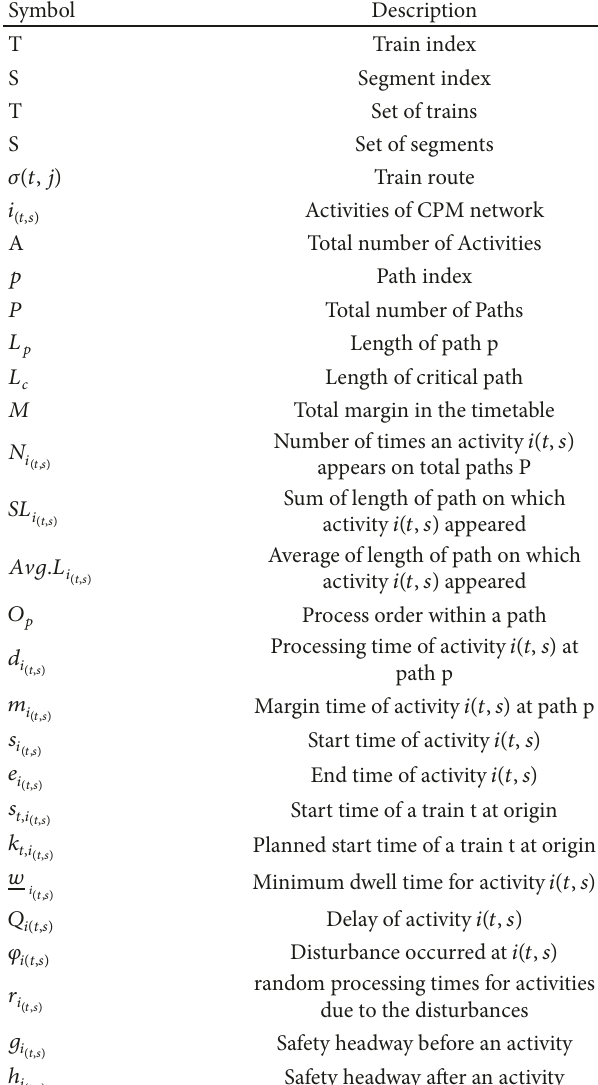
Table 1: Table of